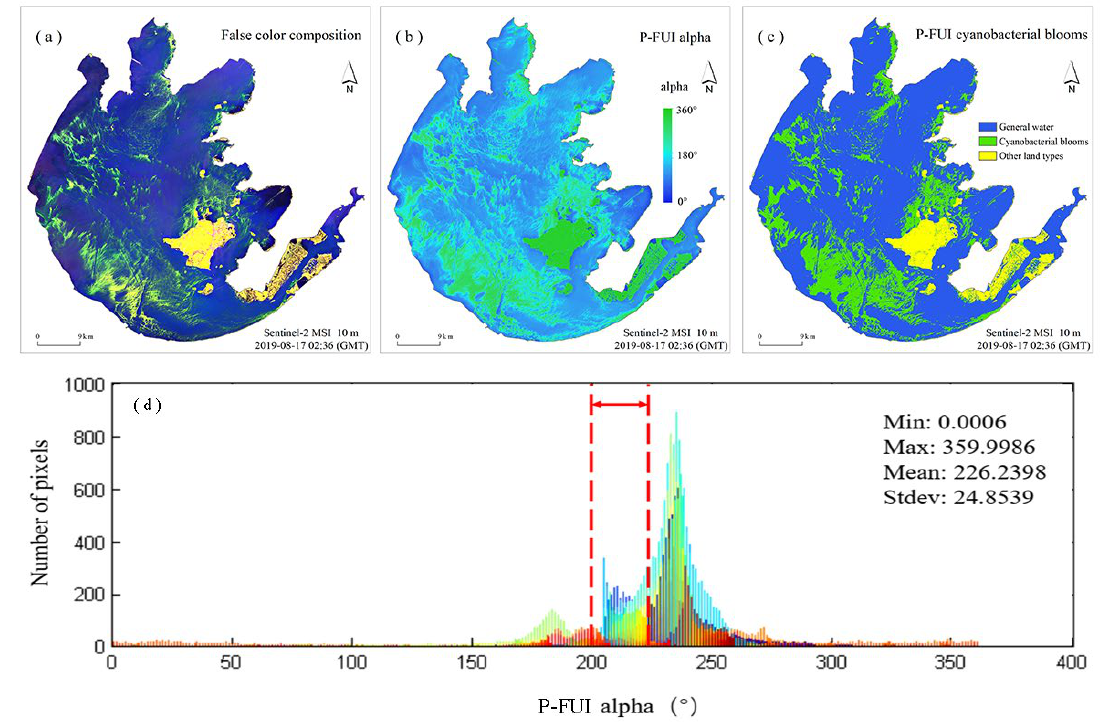
Figure 9. Schematic of obtaining the P-FUI alpha threshold based on MSI sensor, with the ( a ) false color composition, ( b ) P-FUI hue angle distribution, ( c ) results of CBs distribution based on hue angle, and ( d ) threshold frequency distribution histogram of hue angle.